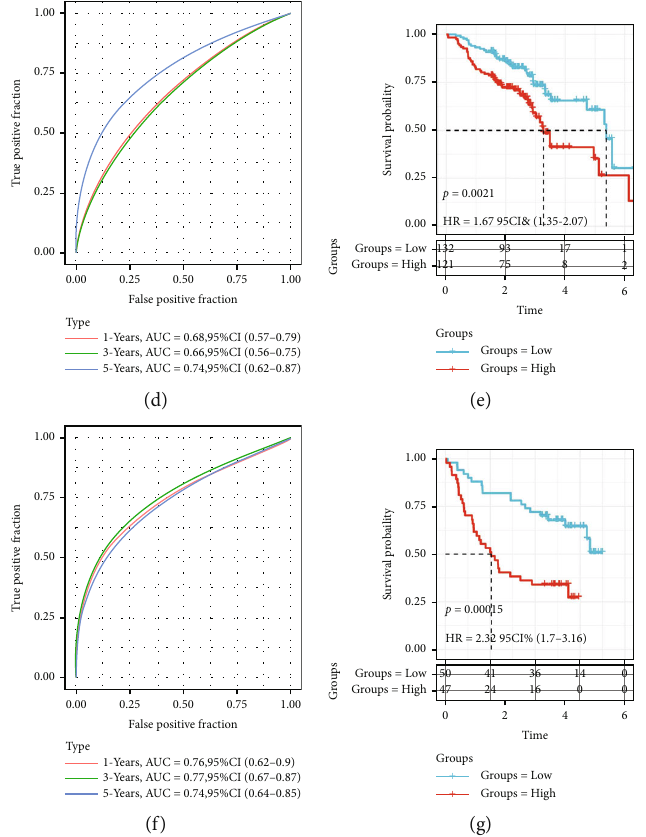
Figure 5: Clinical prognostic modeling and validation. (a) The distribution of survival status, CSRS.Score, and survival time corresponding to senescence-related genes expression in the TCGA cohort. (b) ROC curve with AUC for CSRS.Score classi fi cation in the TCGA cohort. (c) KM survival curves of two risk groups in the TCGA cohort. (d, e) ROC curves and KM survival curves of CSRS.Score in the GSE65858 cohort. (f, g) ROC curves and KM survival curves of CSRS.Score in the GSE41613